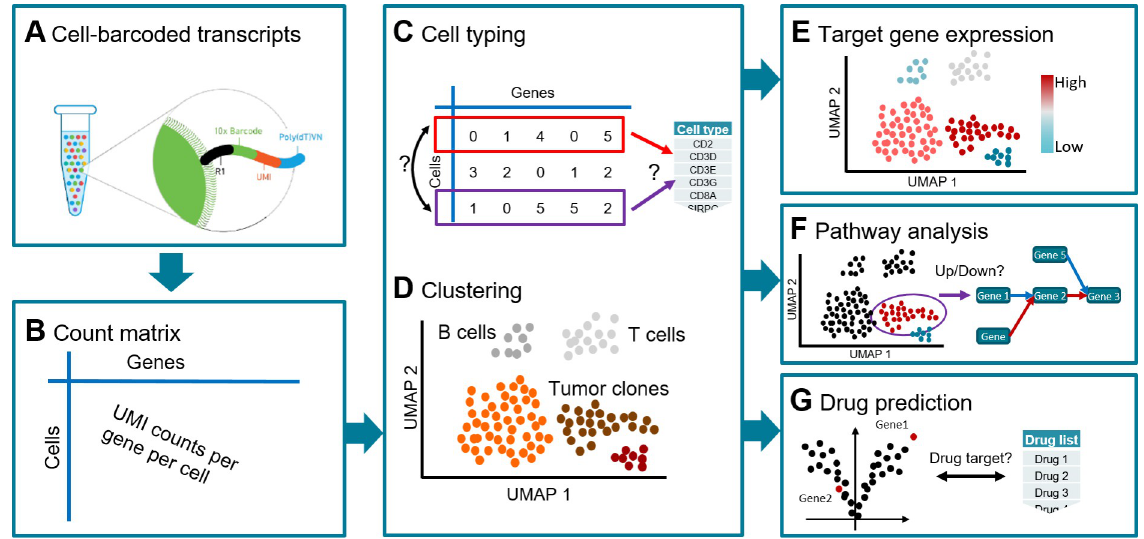
Fig 1. Overview of the workflow implemented in scAmpi, showing a tumor sample analysis as an example. Starting from droplet-based 10x Genomics raw data (A), genome-wide read counts for each cell are generated (B). This gene-by-cell count matrix is the basis for cell type prediction (C) and unsupervised clustering (D) to determine the cell type composition and tumor heterogeneity. Subsequent steps include gene expression (E) and gene set (F) analysis, and drug candidate identification (G).